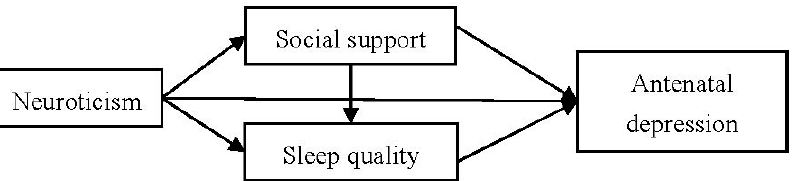
Figure 1. The predefined path model (pathways from neuroticism, social support, and sleep quality to antenatal depression during the third trimester of pregnancy).